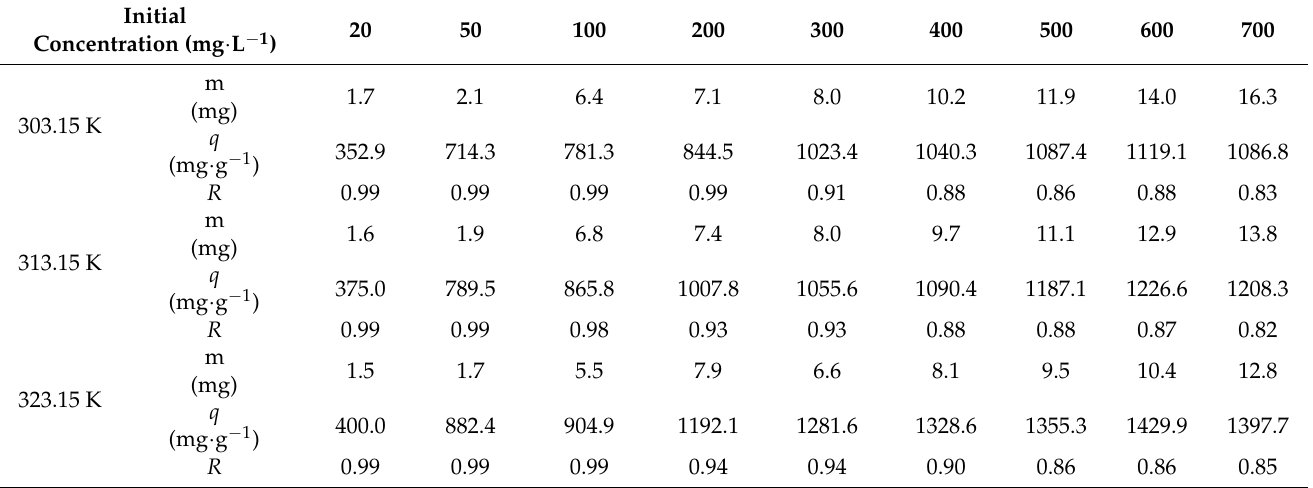
Table 5. The relationship between the adsorption capacity and removal efficiency of chestnut shell-based activated carbon and the initial MB concentration MB at different temperatures.